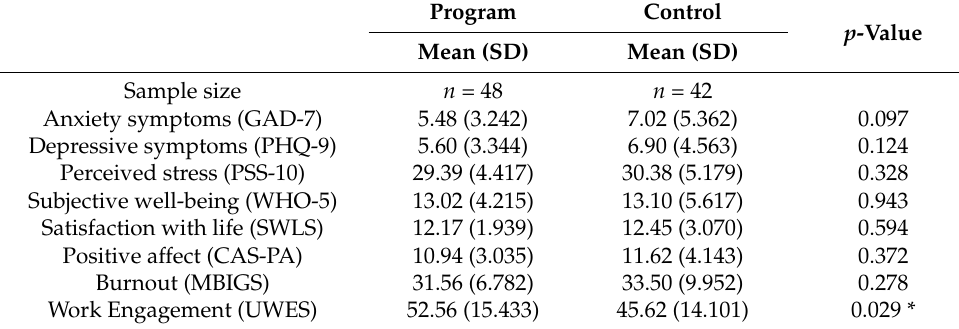
Table A2. Descriptive statistics of the outcome variable at